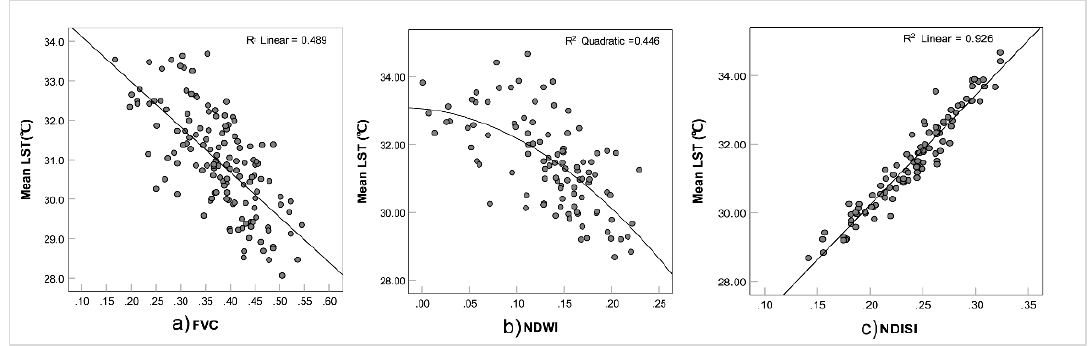
Figure 3. Regression analysis among mean park LST and, ( a ) FVC, ( b ) NDWI, ( c ) NDISI.